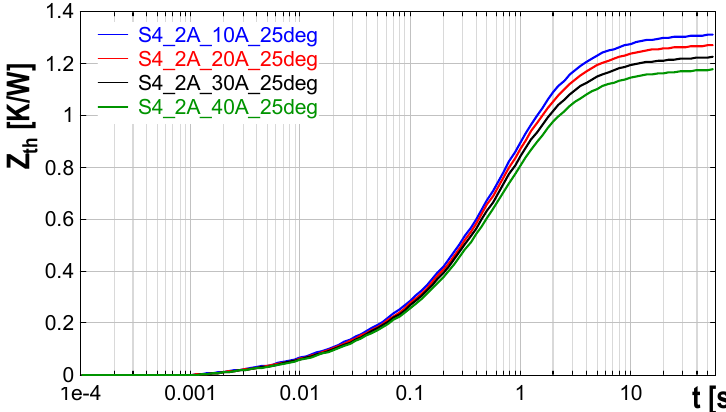
Figure 20. Z th curves calculated from powers of Table 1 at cold plate temperature of 25 °C.